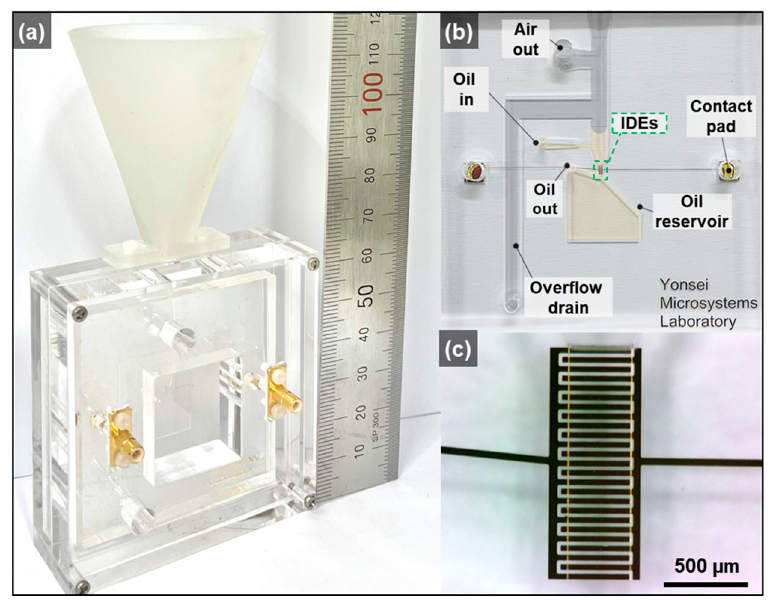
Figure 6. Optical paragraphs of ( a ) the proposed packaged system, ( b ) the microfluidic MP detection chip, and ( c ) the microfabricated interdigitated electrodes as a particle detection element.